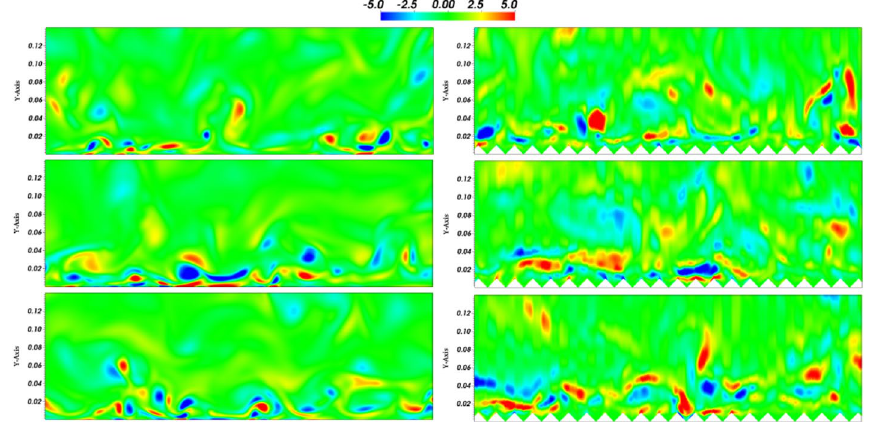
Fig. 16 Distribution of streamwise vorticity fluctuation w x ’ in three moments (Left: smooth flat-plate case; Right: riblets-controlled